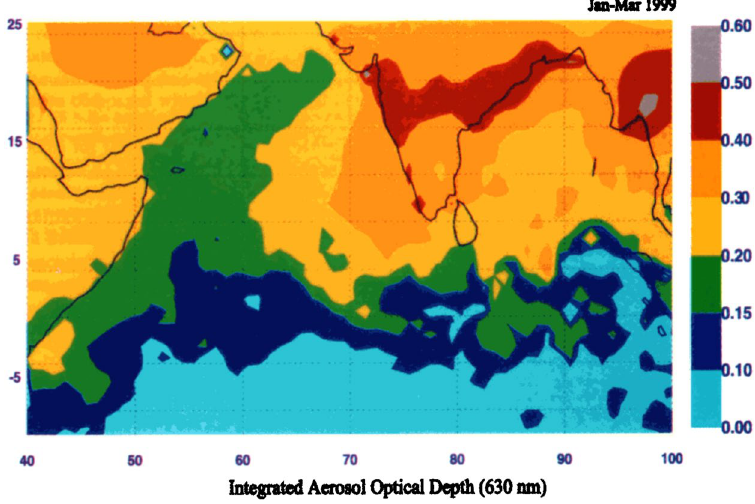
Figure 6. Regional map of aerosol optical depth for the period January to March 1999 9